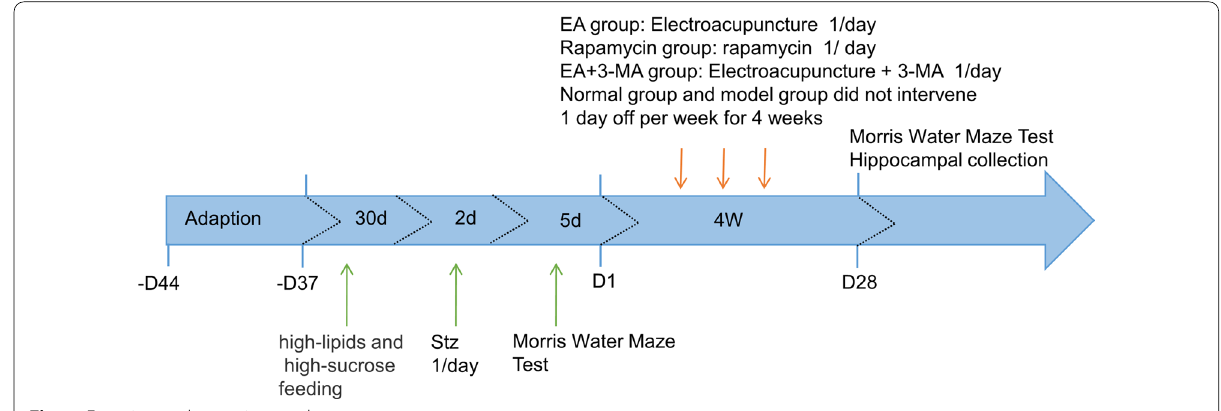
Fig. 1 Experimental grouping